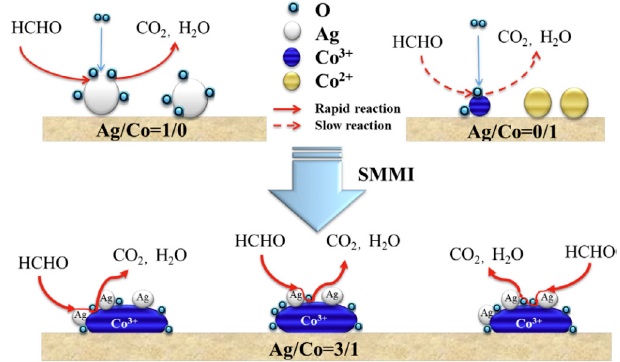
Figure 8. Formaldehyde oxidation on monometallic Ag / MCM-41, Co / MCM-41 and bimetallic Ag-Co / MCM-41. Figure from [120]. Copyright 2014, Elsevier.